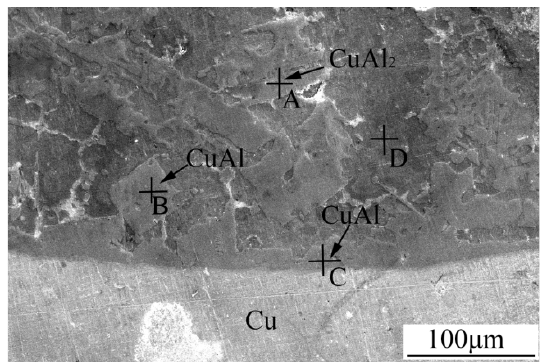
Figure 9. SEM image of Cu/brazing seam interfaces of 3003 Al/Cu joints brazed by Zn-25Al.